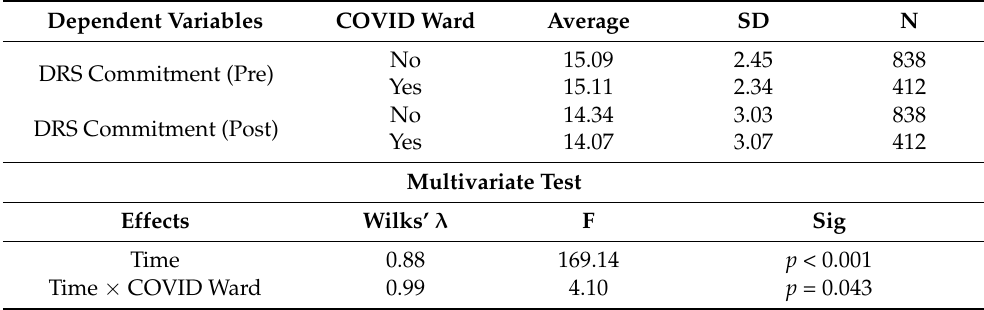
Table 6. Repeated measures ANOVA model of time (i.e., pre- and post-pandemic first-wave effect) and ward effects on DRS commitment. The model assesses the impact of the first wave of COVID-19 on the commitment subscale for nurses directly involved in caring for COVID-19 patients and on those who did